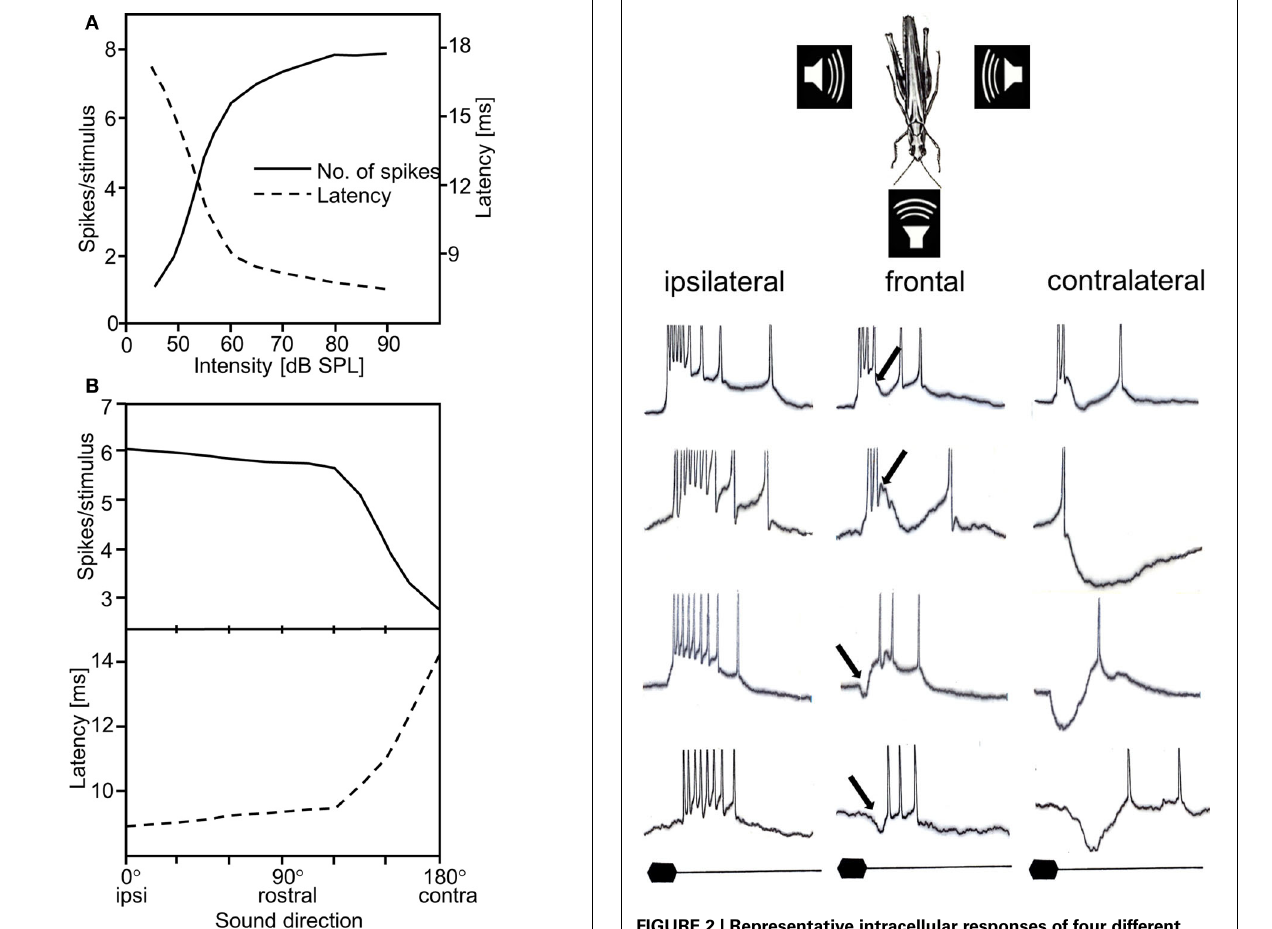
FIGURE 1 | (A) Inverse relationship of spike count and response latency in locust auditory receptors. (B) As a result of the high correlation between both, two directional cues are available for the central nervous system when the sound source is moved from ipsi- to contralateral: spike count and latency differences (modified from Mörchen et al., 1978).